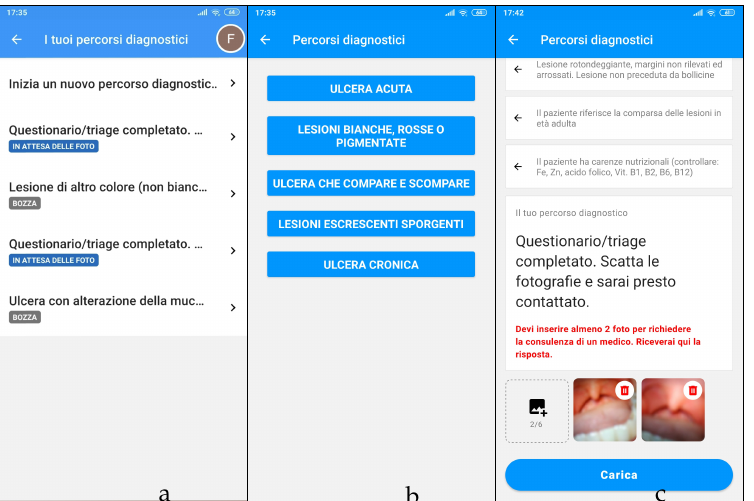
Figure 3. Requests started by a user with their relative statuses color-coded, e.g., “draft” in grey and “waiting for photos” in blue ( a ). First choice of a path ( b ). Request awaiting submission, with all choices already taken and showing the interface for adding photos ( c ). LinguApp features Italian phrases that can be translated quite easily (please see Additional Material).